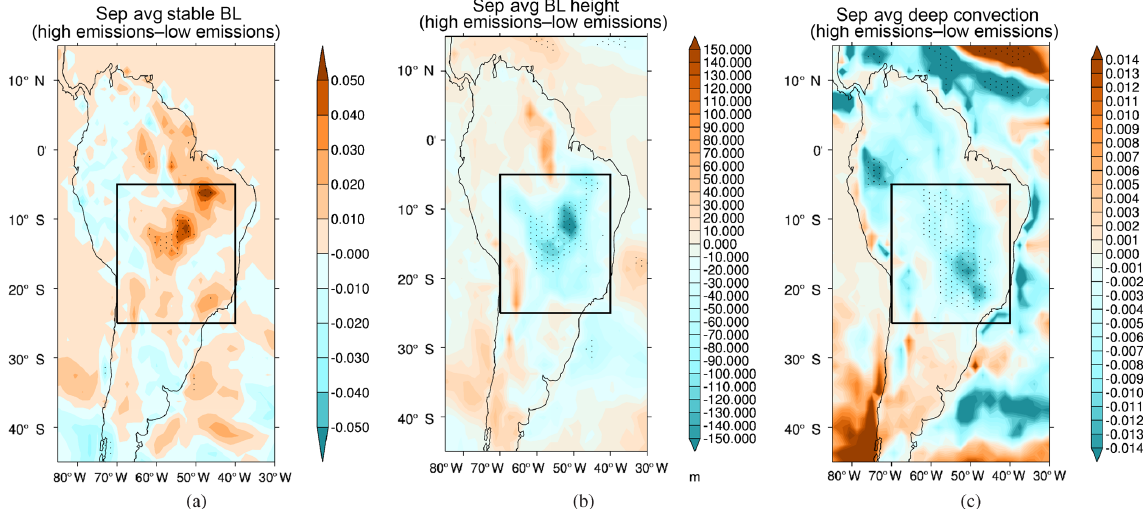
Figure 8. (a) Plot of the September difference in the boundary layer stability diagnostic between the high and low emissions experiment. (b) Plot of the September difference in the boundary layer height between the high and low emissions experiment (m). (c) Plot of the September difference in the deep convection diagnostic between the high and low emissions experiment. Stippling represents 95% confidence limit.